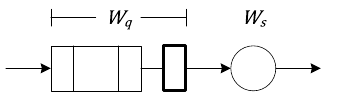
Figure 6. Single queueing station of system.